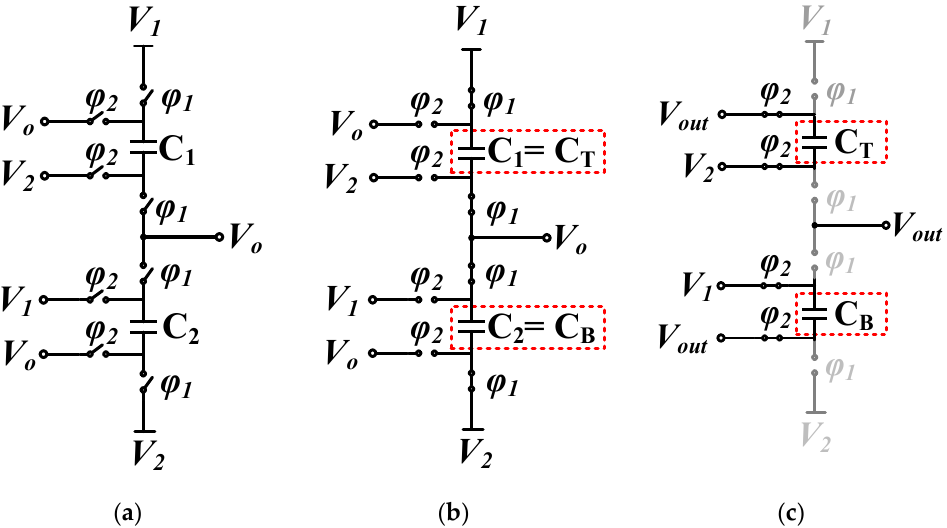
Figure 1. The basic unit cell of the proposed SSC (Swapping Switched-capacitor): ( a ) Schematic of the unit cell; ( b ) phase 1; and ( c ) phase 2.